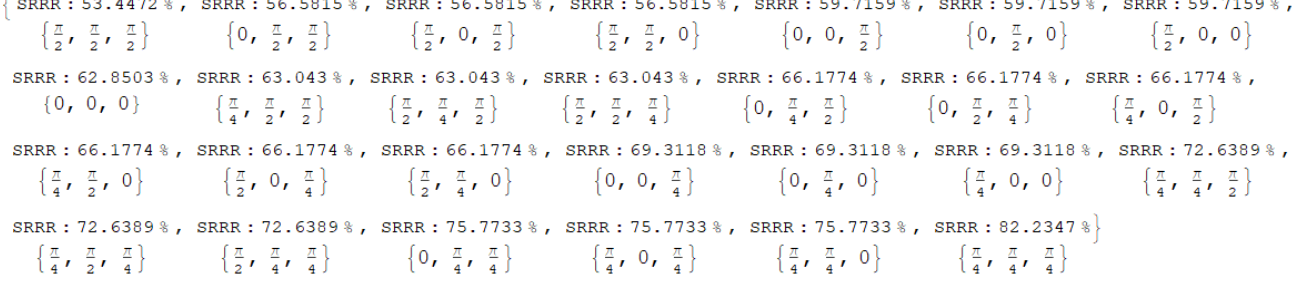
Figure 10. Solar Radiation Reception Rate for m = 3 and n = 2 at the summer solstice in the region of Makkah, Saudi Arabia.